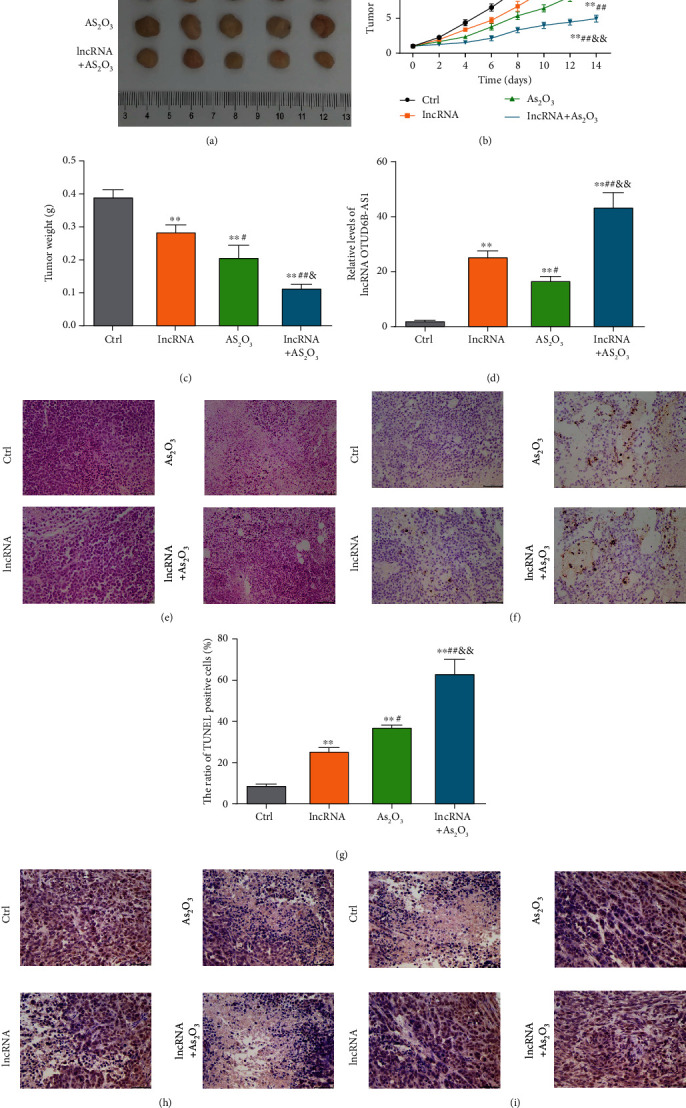
lncRNA OTUD6B-AS1 exacerbates As2O3-induced cytotoxicity in vivo. (a) Harvested xenotransplanted tumors following lncRNA OTUD6B-AS1 overexpression or treatment with 5 mg/kg As2O3. (b) Volume and (c) weight of the harvested tumors. (d) Levels of lncRNA OTUD6B-AS1 in harvested transplanted tumors determined by qRT-PCR. Bladder cancer xenograft tumors were stained with (e) H&E and (f) TUNEL. Scale bar: 50 μm. (g) Statistical analysis of cells positive for TUNEL staining in bladder cancer xenotransplanted tumors. Bladder cancer xenograft tumors were evaluated by immunohistochemistry staining using antibodies against (h) Ki-67 and (i) p57. Scale bar: 50 μm. ∗P < 0.05, ∗∗P < 0.01 vs. control xenotransplanted tumors; #P < 0.05, ##P < 0.01 vs. transplanted tumors with lncRNA OTUD6B-AS1 overexpression; &P < 0.05, &&P < 0.01 vs. transplanted tumors treated with 5 mg/kg As2O3.